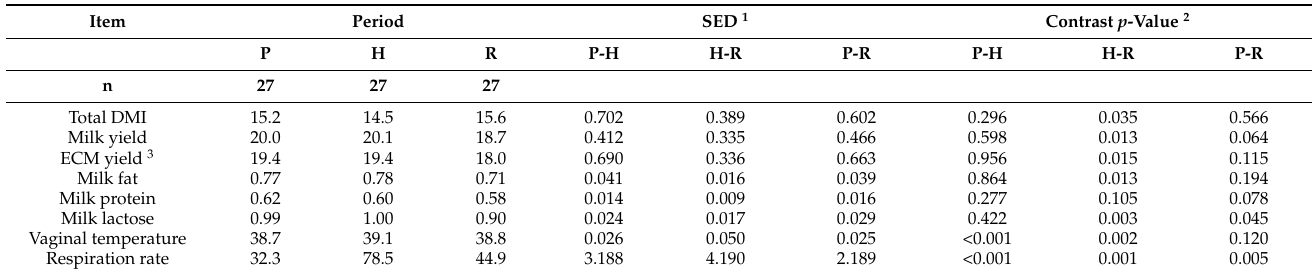
Table 4. Comparisons of the effects of pre-challenge (P), heat challenge (H) and recovery (R) periods on means of total DMI (kg/day), milk yield (kg/day), ECM yield (kg/day), milk fat concentration (g/kg), milk protein concentration (g/kg), milk lactose concentration (g/kg), vaginal temperature ( ◦ C) and respiration rate